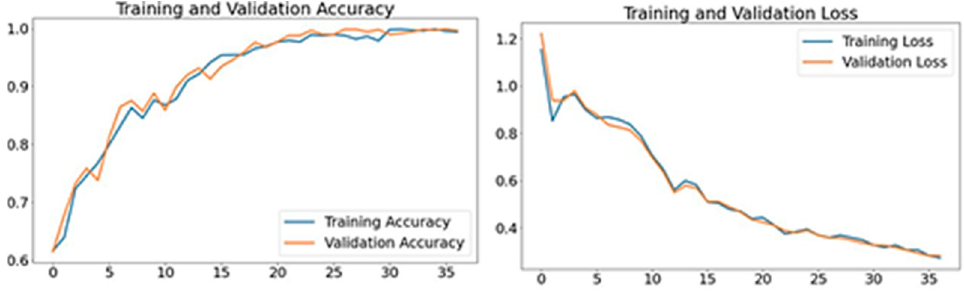
Figure 14. Accuracy and loss of Y_PN-MSSD model when tested with same dataset. The loss of training and test datasets gradually decreased from epoch 0 to 200. The model does not appear to be over fitting based on the training and validation